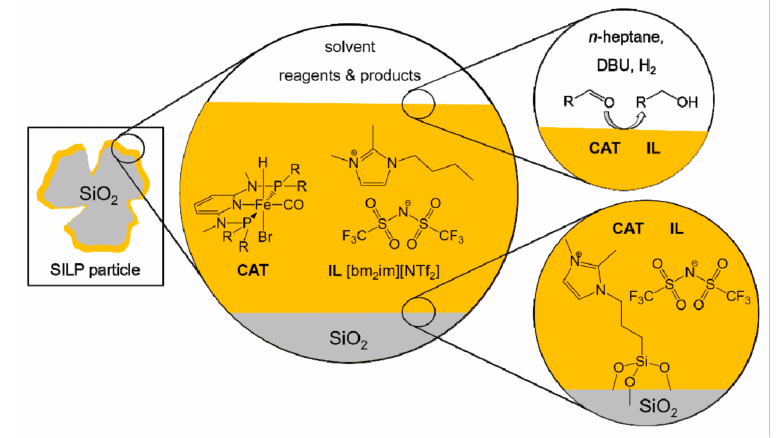
Figure 17. Structure of the SILP catalytic system exploited by Kirchner et al. with [bm 2 im][NTf 2 ] as IL anchored on silica particles and [Fe(PNP-Me- i Pr)(CO)(H)(Br)] as pre-catalyst ( CAT ) [94].